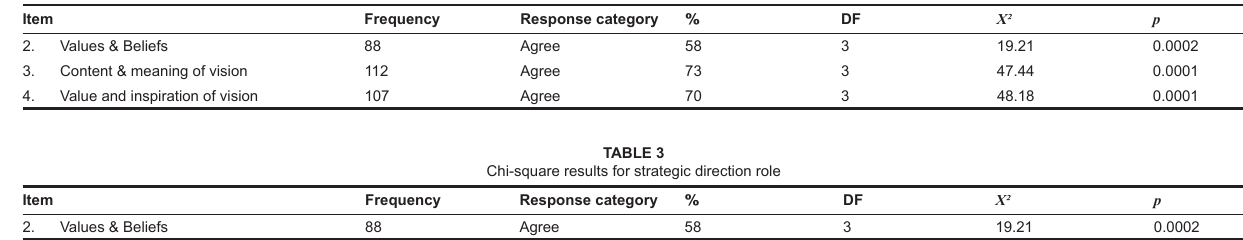
Table 2 Chi-square result for shared vision role